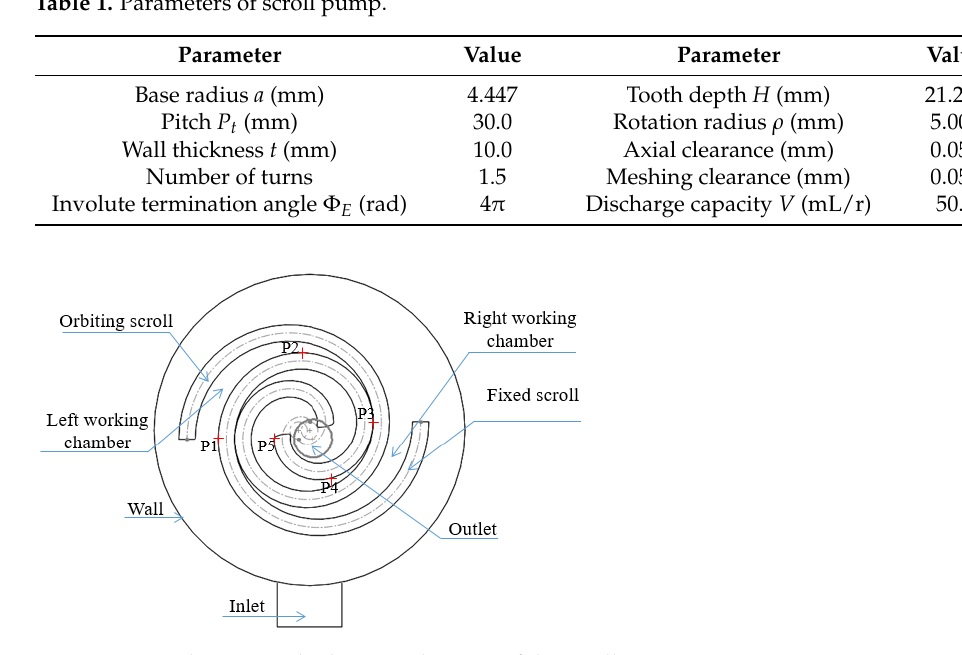
Figure 2. Two ‐ dimensional schematic diagram of the scroll pump.